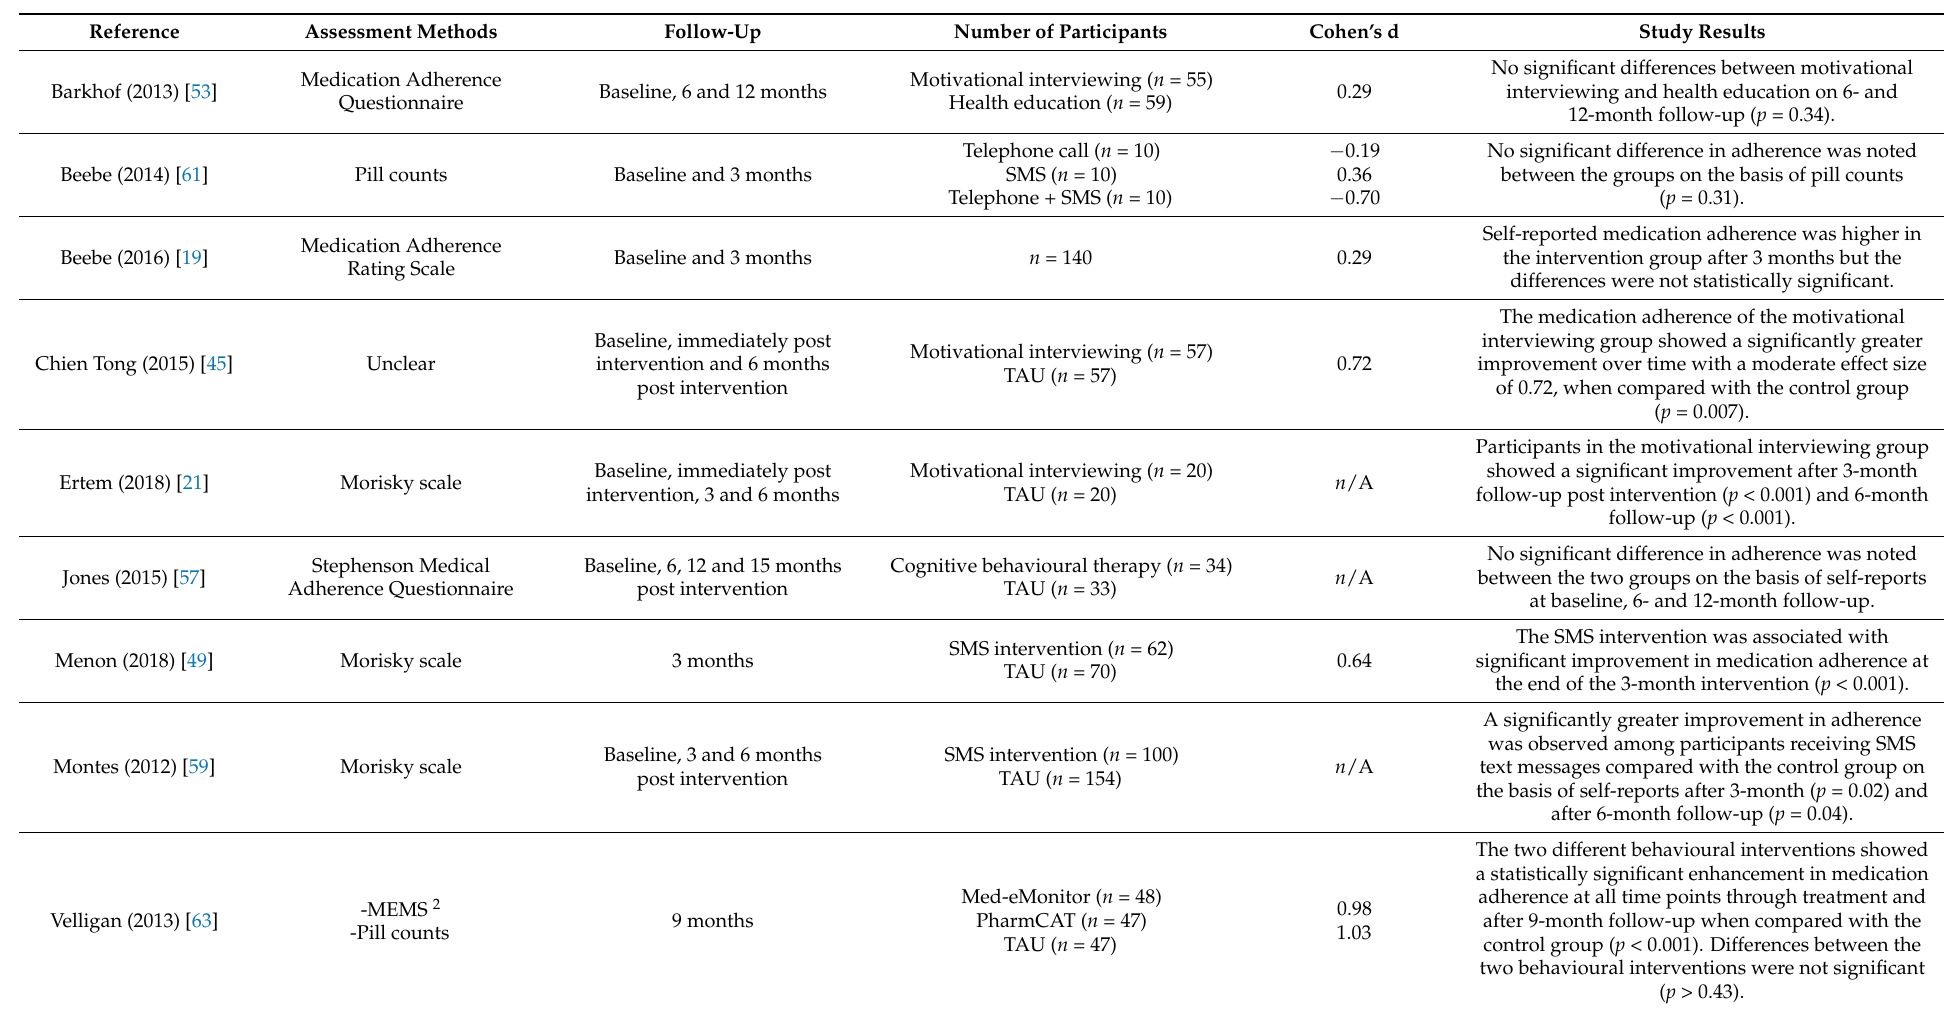
Table 3. Summary of results on the effectiveness of behavioural